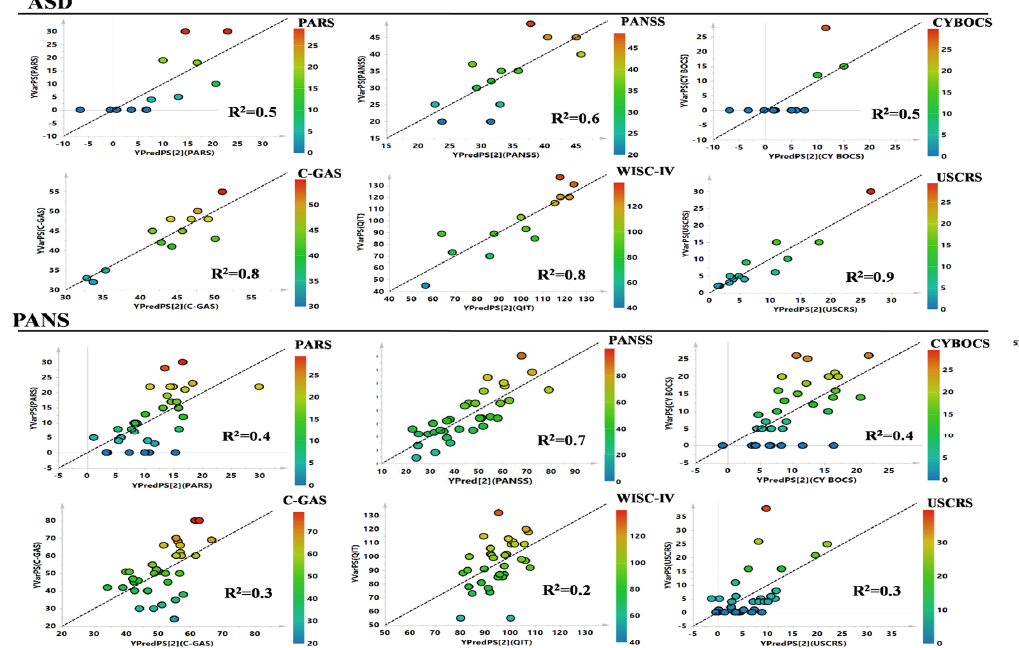
Figure 5. PLS correlation analysis between the metabolic profiles of the three classes of patients and clinical parameters. Clinical parameters were assessed by PARS (Pediatric Anxiety Rating Scale), PANSS (Pediatric Acute Neuropsychiatric Symptom Scale), CYBOCS (Children’s Yale-Brown Obsessive Compulsive Scale), YGTSS (Total Yale Global Tic Severity Scale score), C-GAS (Children’s Global Assessment Scale), WISC-IV (Wechsler Intelligence Scale for Children), and USCRS (UFMG Sydenham’s Chorea Rating Scale). ASD = autism spectrum disorder; PANS = pediatric acute-onset neuropsychiatric syndrome; R 2 = coefficient of determination. Dots represent patients. YGTSS was omitted for the ASD class because only two patients exhibited concurrent tic disorders. PLS showed weak correlations for all of the Y parameters in the PANS group, except for the PANSS scale, while strong correlations were identified between the metabolomic profile of ASD metabolomic and clinical scores of C-GAS, WISC-IV, and USCRS (Table 4). Table 4. Statistical results of the PLS correlation analysis. Class